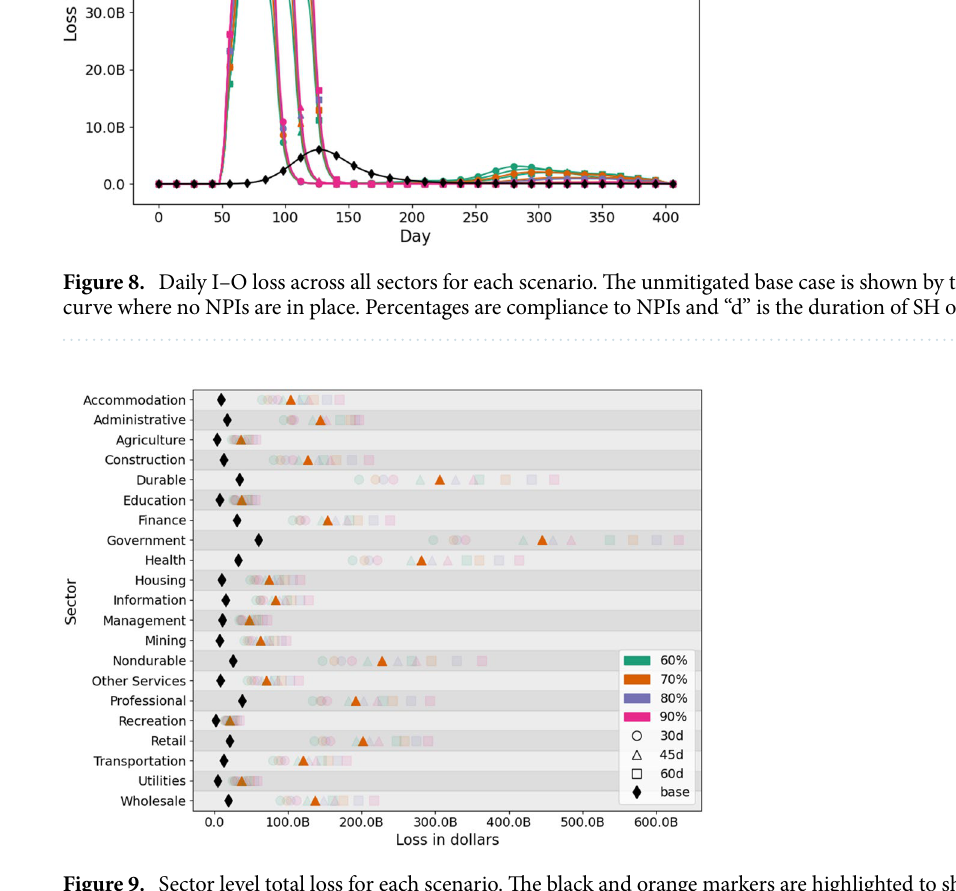
Figure 9. Sector level total loss for each scenario. The black and orange markers are highlighted to show the unmitigated and mitigated case VHI _70_ SH _70_45 respectively. Percentages are compliance to NPIs and “d” is the duration of SH